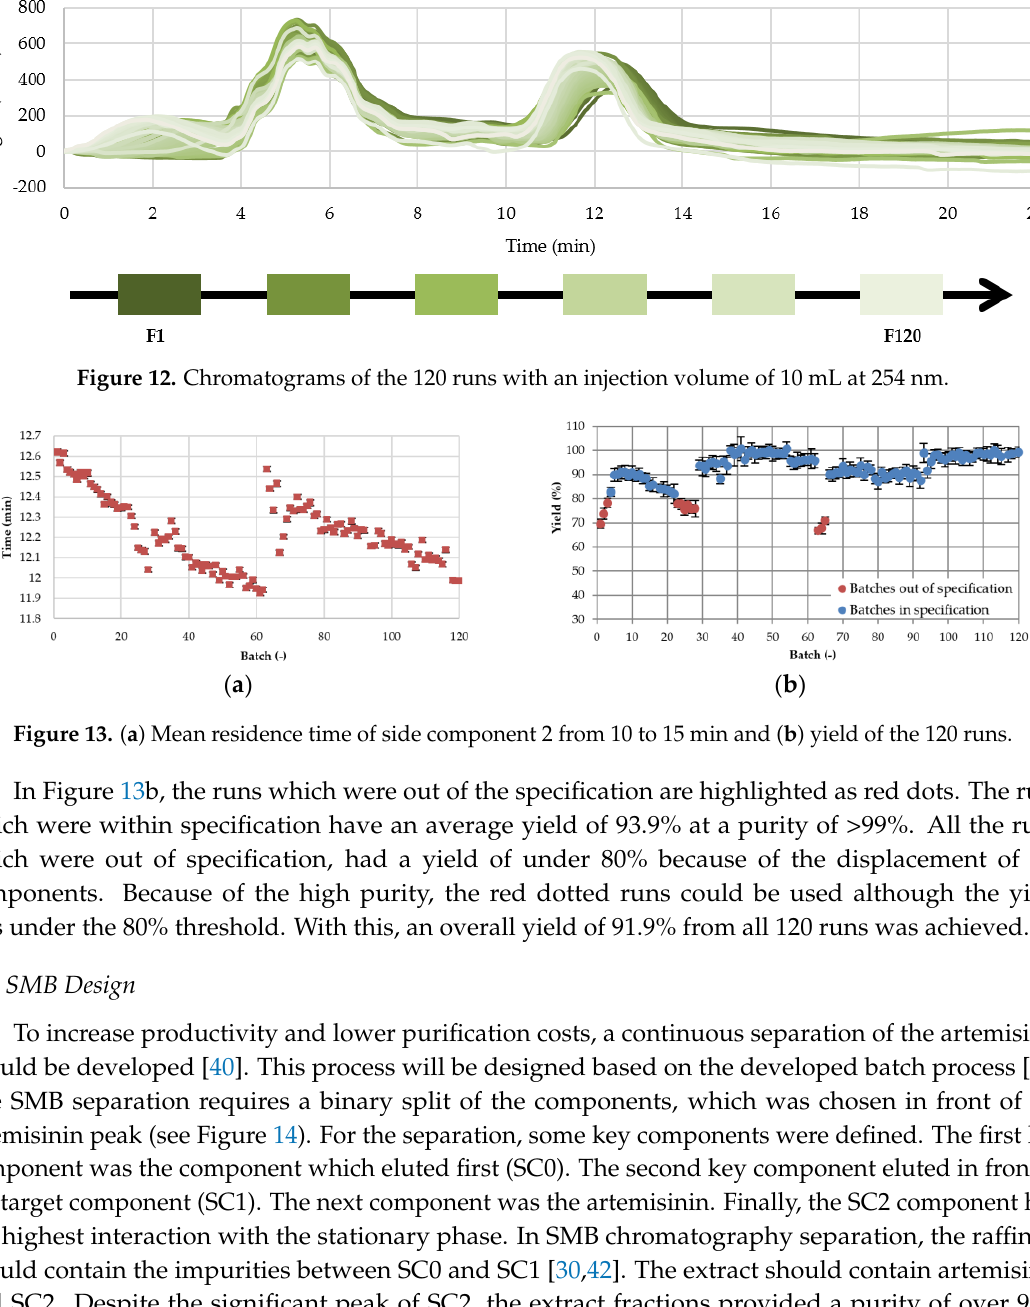
Figure 14. Binary split for the SMB separation and declaration of the key components. Established isotherm determination methods like frontal analysis or the perturbation method are not feasible for this feed composition because of the high number of different components [43]. To design SMB chromatography processes and operation points, the Henry coefficients are determined first experimentally. Therefore, a low concentrated injection was carried out. This approach should lead to linear isotherms for the SMB chromatography step that was used. The split of the SMB separation was between SC1 and the artemisinin. Because of this, the Henry coefficients of SC1 and artemisinin were used to calculate the triangle operation region of the